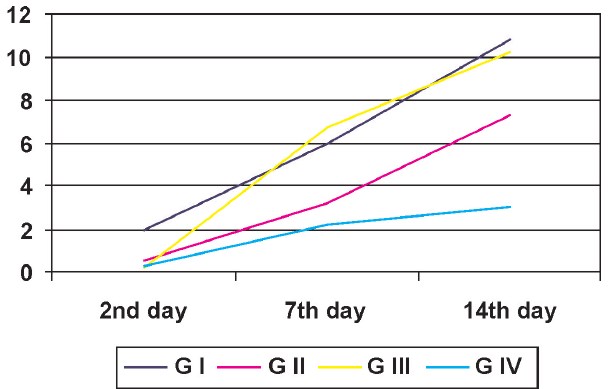
Figure 3 - Evolution of the mean values for functional evaluations, on the second, seventh and fourteenth days after causing the spinal injury, for groups g I, g II, g III and g